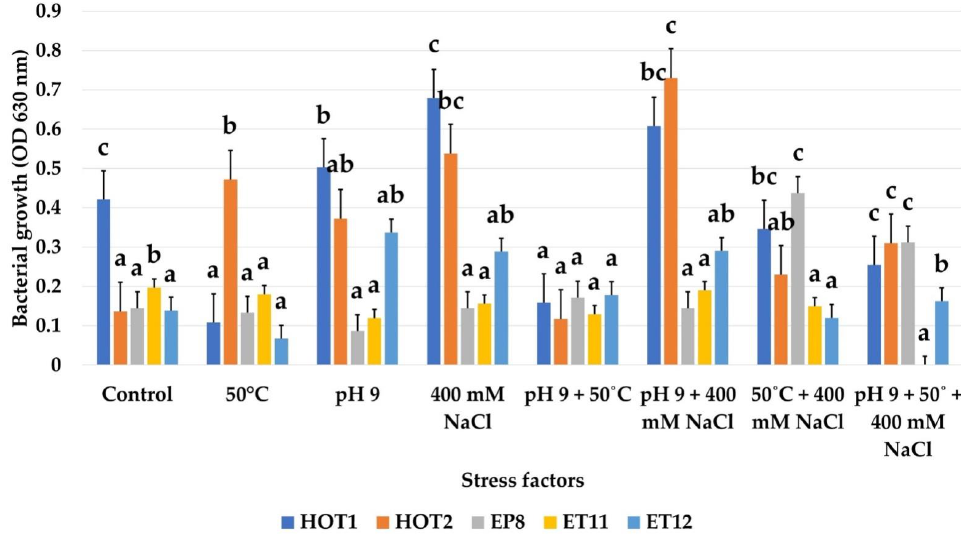
Figure 16. Effect of multiple stresses on bacterial growth in liquid medium. Results are expressed as mean-standard error of duplicate OD values. The stresses effect corresponding to each treatment and not sharing the same letters are significantly different according to Tukey ’ s post hoc HSD test.